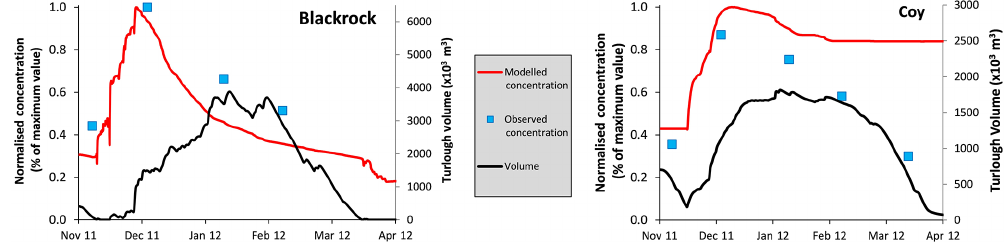
Figure 9. Observed (blue points) and simulated (red line) normalised results of a nutrient plume in a flow-through system (Blackrock) and a surcharge tank system